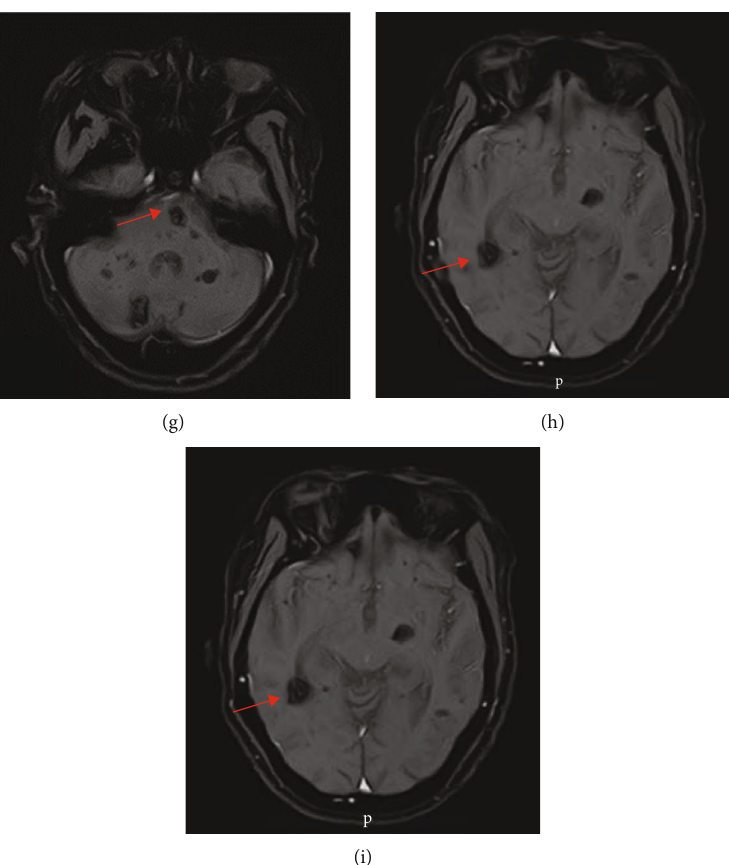
Figure 2: Axial brain MRI: (a – c) T1W, (d – f) T2W, and (g – i) T1W postgadolinium enhanced images showing multiple di ff use cerebellar, pons, bilateral basal ganglia, and cerebral lesions of varying sizes (red arrows); the larger lesions on T1W and T2W images showed hyperintense core and peripheral rim of hypointensity due to hemosiderin in keeping with multiple cerebral cavernomas. No enhancement was noted postgadolinium contrast administration (g –